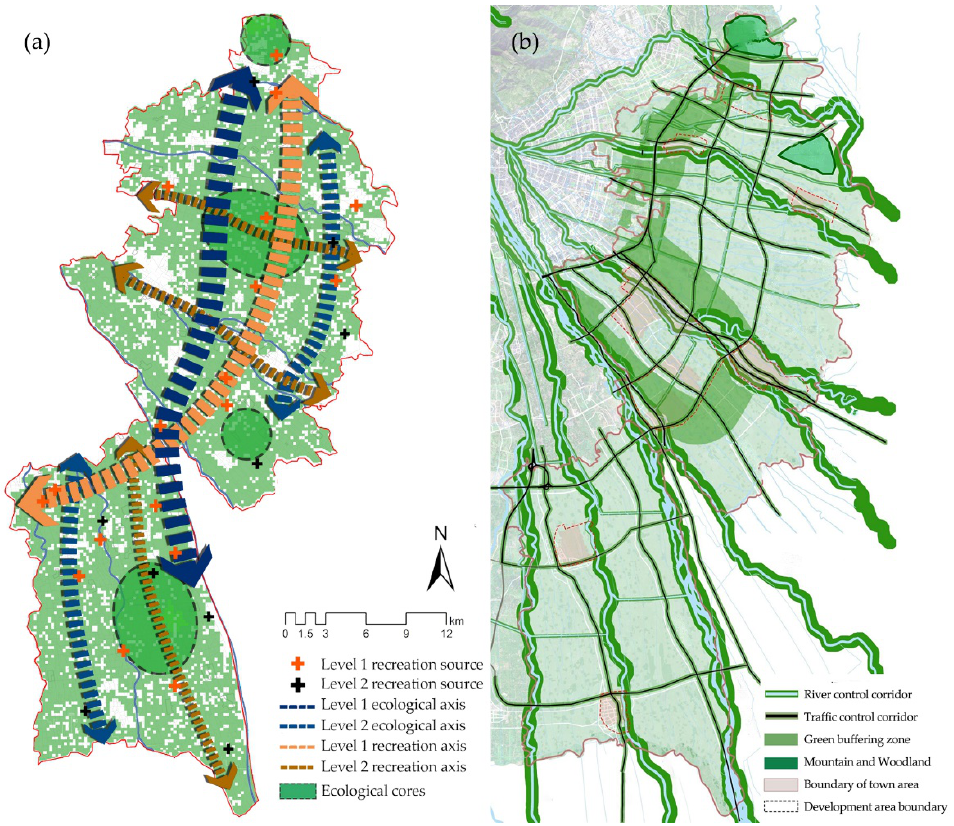
Figure 11. Landscape spatial structure: ( a ) analysis of the landscape spatial structure of the Dujiangyan Irrigation District; ( b ) ecological function zoning in the Master plan of Dujiangyan Irrigation District (Revised by the Dujiangyan Irrigation District Management Committee (2018).